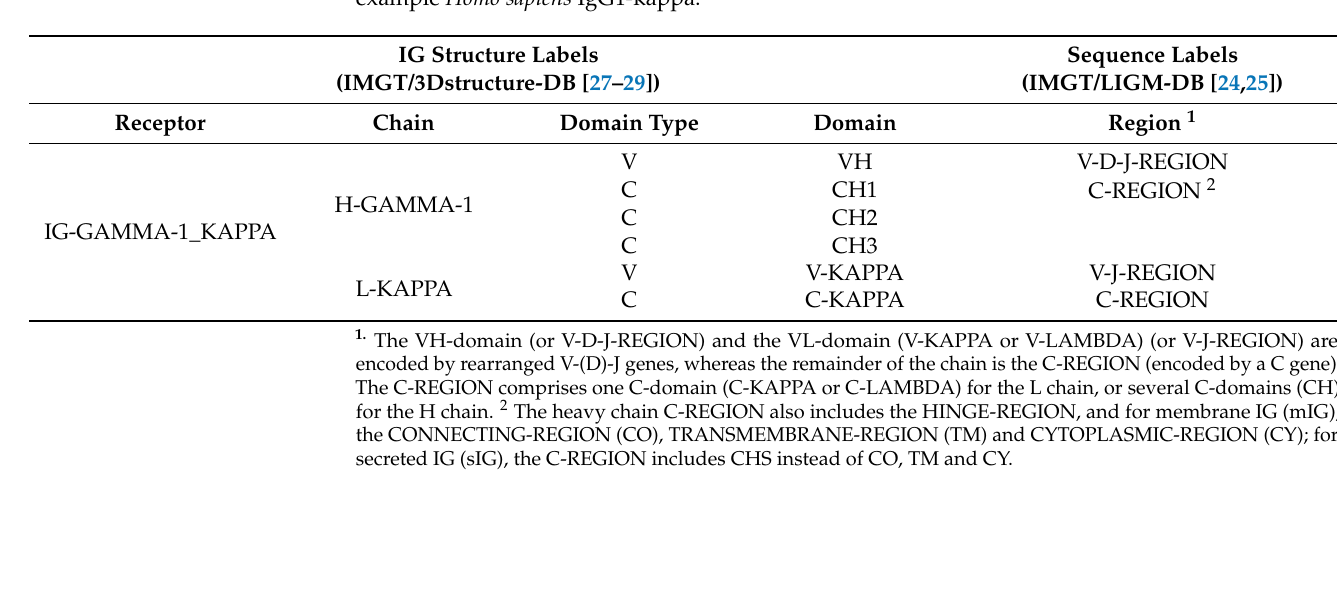
Figure 2. Immunoglobulin IgG1. The structure is that of the antibody b12, an IgG1-kappa, and so far is the only complete human IG crystallized (PDB code: 1hzh, from IMGT ® https://www.imgt.org, IMGT/3Dstructure-DB). H-GAMMA-1 and L-KAPPA (usedfor the chains), VH, CH1, CH2, CH3, V-KAPPA and C-KAPPA (for the domains) are written in capital letters as they are IMGT standardized labels (DESCRIPTION) [1]. This first 3D-structure of a complete Homo sapiens IG shows the expected Y shape with the two Fragment antigen binding (Fab) arms (one L-KAPPA light chain (V-KAPPA-C-KAPPA) paired to the VH-CH1 of each H-GAMMA-1 heavy chain) and the Fragment crystallisable (Fc), made of the paired hinge-CH2-CH3 of the two H-GAMMA-1 heavy chains. The figure also shows the relative position, in space, of the L-KAPPA relative to the VH-CH1 in each Fab (in the front on the left hand side, and the back right hand side). The sequences of the two H-GAMMA1 chains (colored in purple and dark blue for a better visibility) are identical and the sequences of the two L-KAPPA chains (colored in orange and green for a better visibility) are identical (with permission from M-P. Lefranc and G. Lefranc, LIGM, Founders of IMGT ® , the international ImMunoGeneTics information system ® , https://www.imgt.org). Table 3. The immunoglobulin IgG1 receptor, chain and domain structure labels and correspondence with sequence labels. IMGT standardized labels are in capital letters. They are shown with the example Homo sapiens IgG1-kappa.